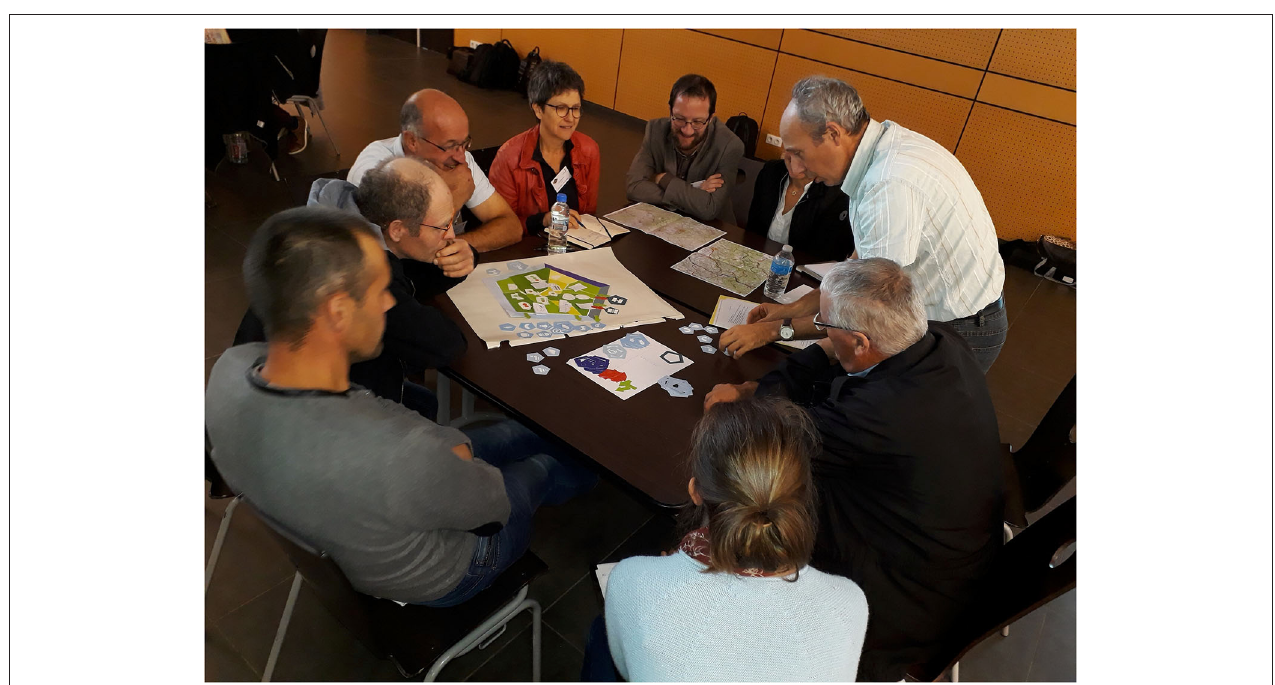
FIGURE 4 | Stakeholders from a French PDO cheese production area (Fourme de Montbrison) playing a game adapted from Ryschawy et al. (2019) socio-ecological framework. It allowed the expression of contrasted and sometimes antagonist viewpoints among stakeholders (Dernat et al., in review). Picture by François